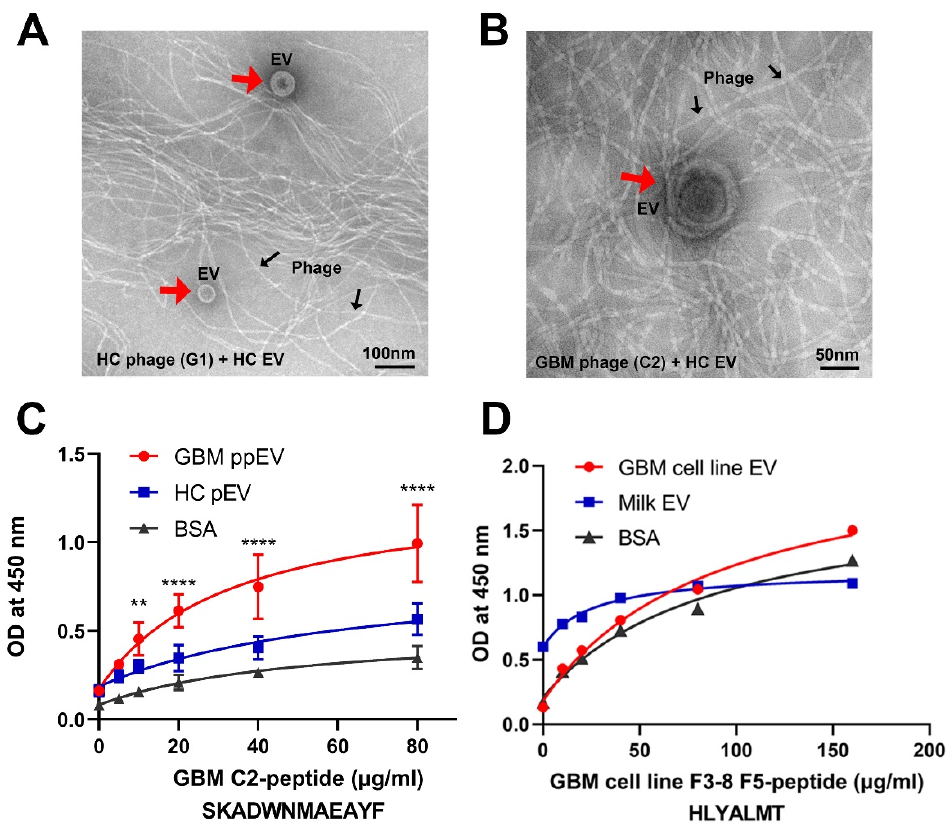
Figure 3. High-affinity bindings of phage peptides to GBM EVs are demonstrated by electron microscopy and synthetic peptide ELISA. ( A , B ) Electron microscopic images showing EVs precipitated by phage peptides. GBM EV phage C2 and HC EV phage G1 (2 × 10 10 pfu) were incubated with HC-EVs (100 µg) overnight at 4 °C. The EV–phage complexes were precipitated by PEG 8000/NaCl, dissolved in PBS followed by transmission electron microscopy. ( A ) HC G1 phage and HC EVs. ( B ) GBM C2 phage and HC EVs. The EVs (red arrows) precipitated by M13 phage (black arrows) show typical spherical shapes with size ranges of 50–200 nm in diameter. Notice that samples in image